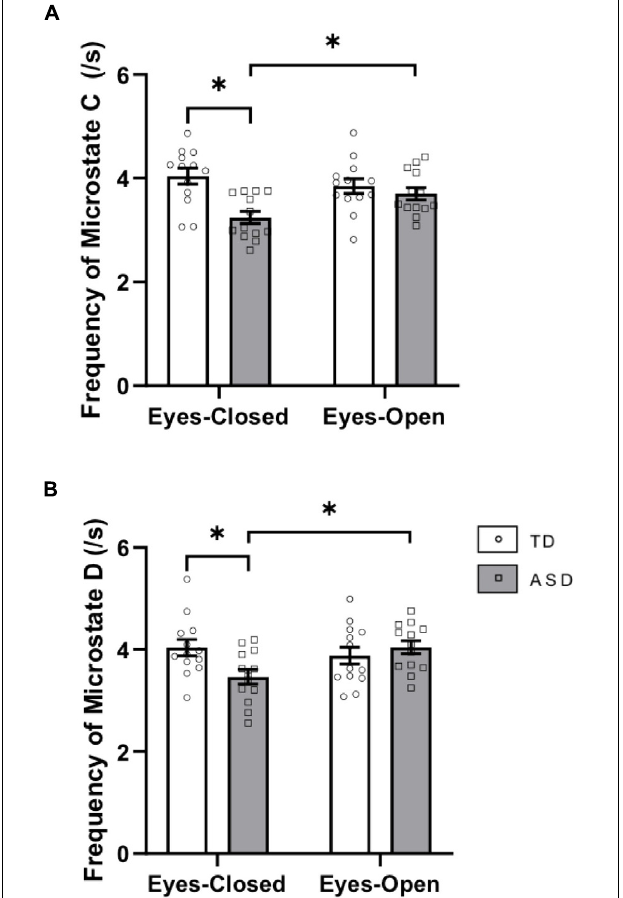
FIGURE 3 | Frequency of (A) microstate class C and (B) microstate class D in EC and EO for the two groups. These graphs display the mean frequencies of each microstate with corresponding standard error of the mean. The white and gray bars display results from the TD and ASD groups, respectively. individual participant data is plotted on each bar. All significant differences are indicated with asterisks ( p < 0.0125, Bonferroni